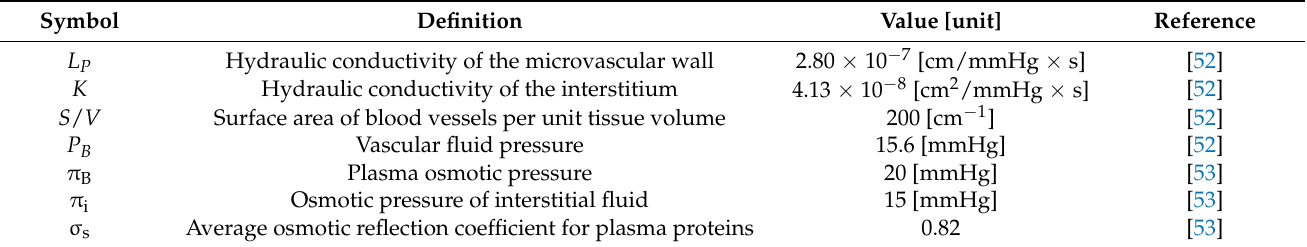
Table 2. Interstitial transport properties used in the modeling of the transport of MNPs in